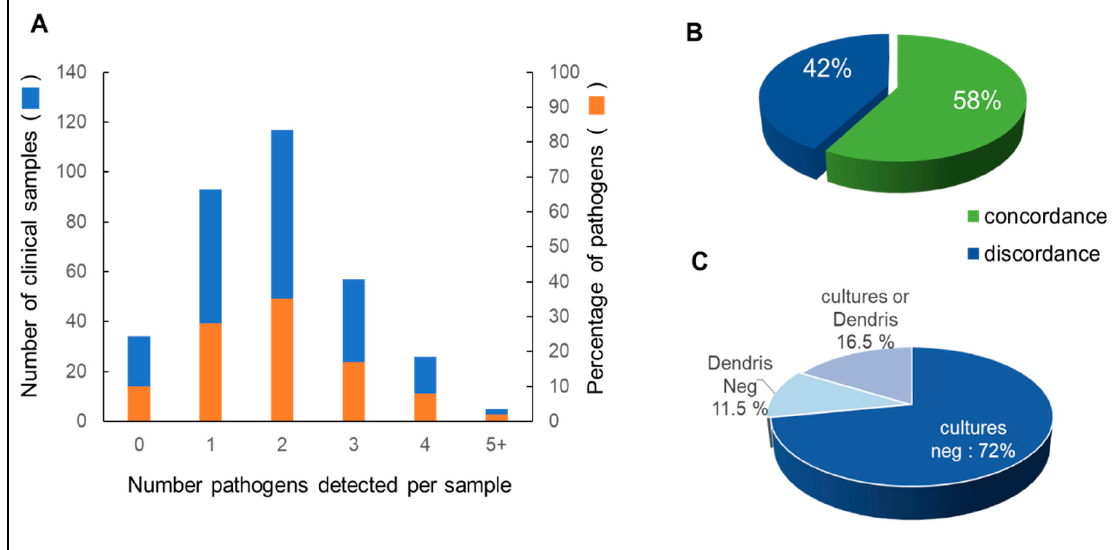
Figure 1. Detection of pathogen bacteria in isolates by DendrisCHIP ® OA and microbial cultures. In ( A ) is represented the number of pathogens per sample as detected by DendrisCHIP ® OA. In ( B ) is shown the concordance and discordance in the detection of bacteria by DendrisCHIP ® OA and by the microbial cultures. In ( C ) is reported the distribution of the discordant results with respect to the detection by microbial culture and by DendrisCHIP ® OA. Culture Neg = negative by microbial culture/positive by DendrisCHIP ® OA; Dendris Neg = negative by DendrisCHIP ® OA/positive by microbial cultures; culture or Dendris = either one or the other as negative or positive.